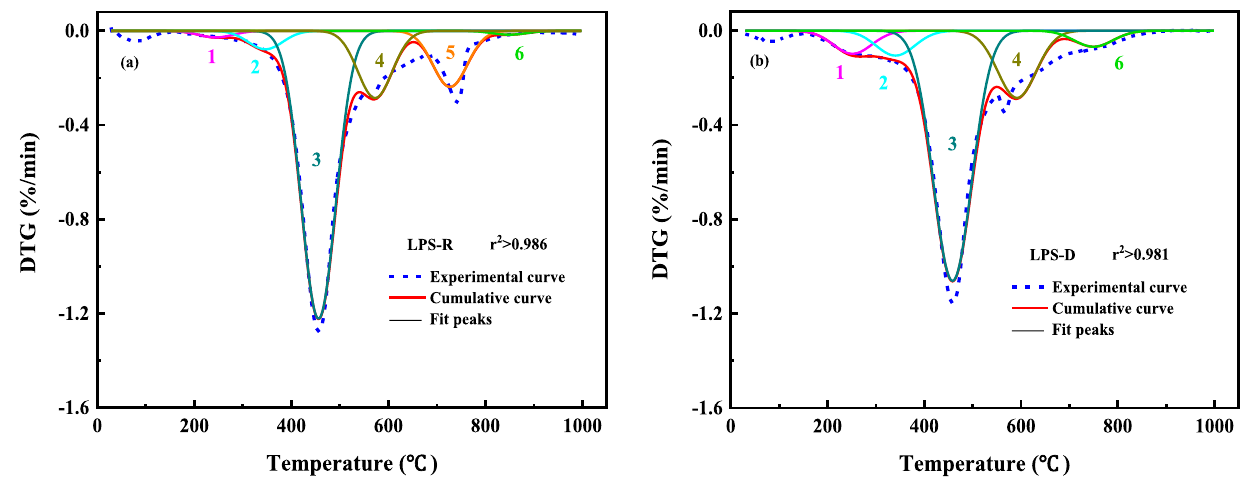
Fig. 6 DTG curve of LPS-R and LPS-D fitted by subcurves Table 8 Fitting results of DTG curve